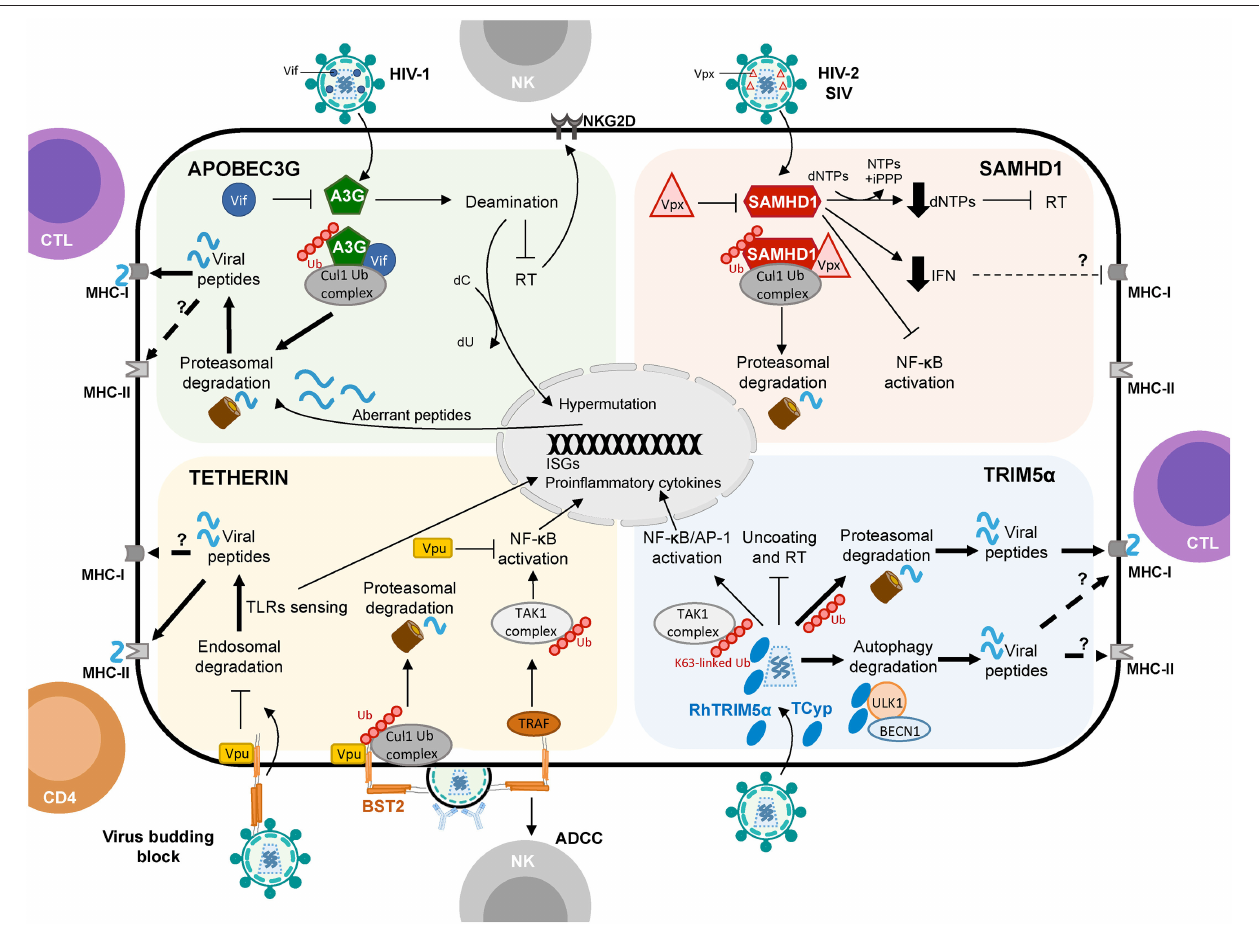
FIGURE 1 | Schematic representation of APOBEC3G, SAMHD1, Tetherin, and TRIM5 α proteins shaping cellular innate and adaptive immune responses against viruses with a focus on HIV-1 infection. Restriction factors link to protein degradation pathways and their connection to CD4 + T cell and CTL responses are depicted by thick arrows. Question marks (?) and broken arrows represent questions and unresolved pathways. Restriction factors respective counteracting proteins are also shown.